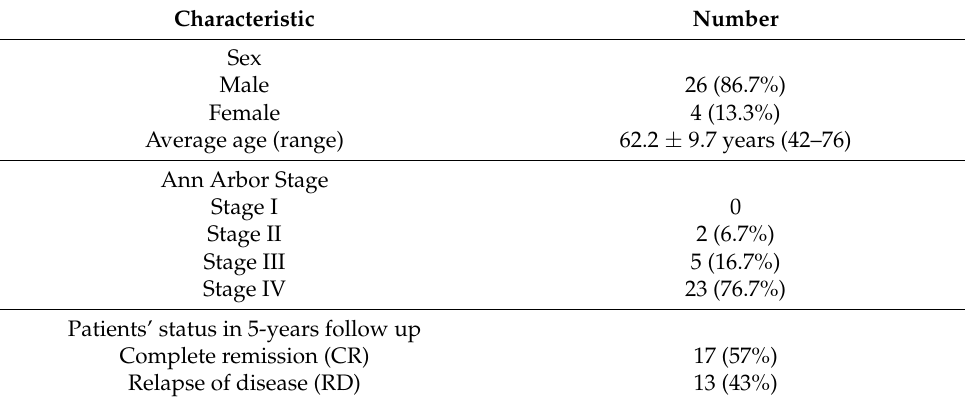
Table 1. Baseline demographic and clinical